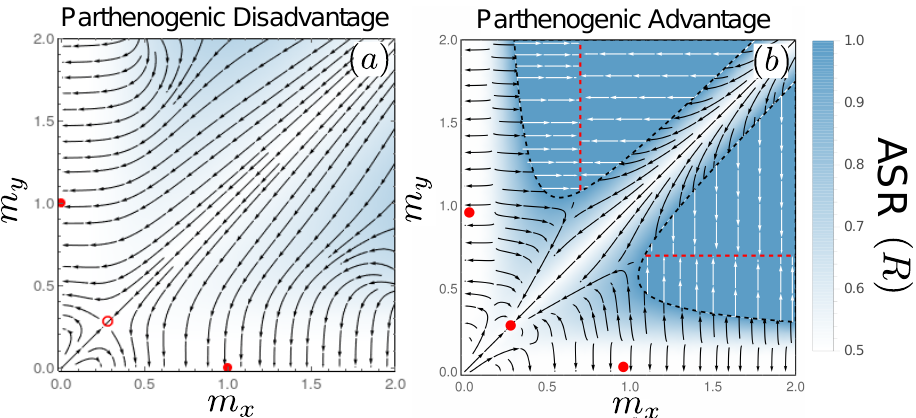
Figure 4. Evolutionary Dynamics under Mixed Sexual and Parthenogenic Reproduction. Evo- lutionary dynamics when both mating types are present are plotted as gray arrows (see Equations (9) and (10)) while evolutionary dynamics when only one mating type is present are plotted as white arrows (Equation (7))). When β p > β z (panel ( a )) isogamy is unstable (open red circle) and anisogamy is stable (solid red disks). Certain regions of state space are biased towards higher adult sex ratios of the microgamete (blue overlay). When β z > β p (panel ( b )) isogamy and anisogamy are both stable states (solid red disks) and regions emerge where macrogamete producers are driven to extinction (deeper blue region) and for which microgamete producers evolve to produc- ing “gametes” of mass β p (dashed red lines). Parameters used are β z = 1, β p = 1.3 (panel ( a )) and β z = 1, β p = 0.7 (panel ( b )). These panels are plotted over a larger region of state space in Figure